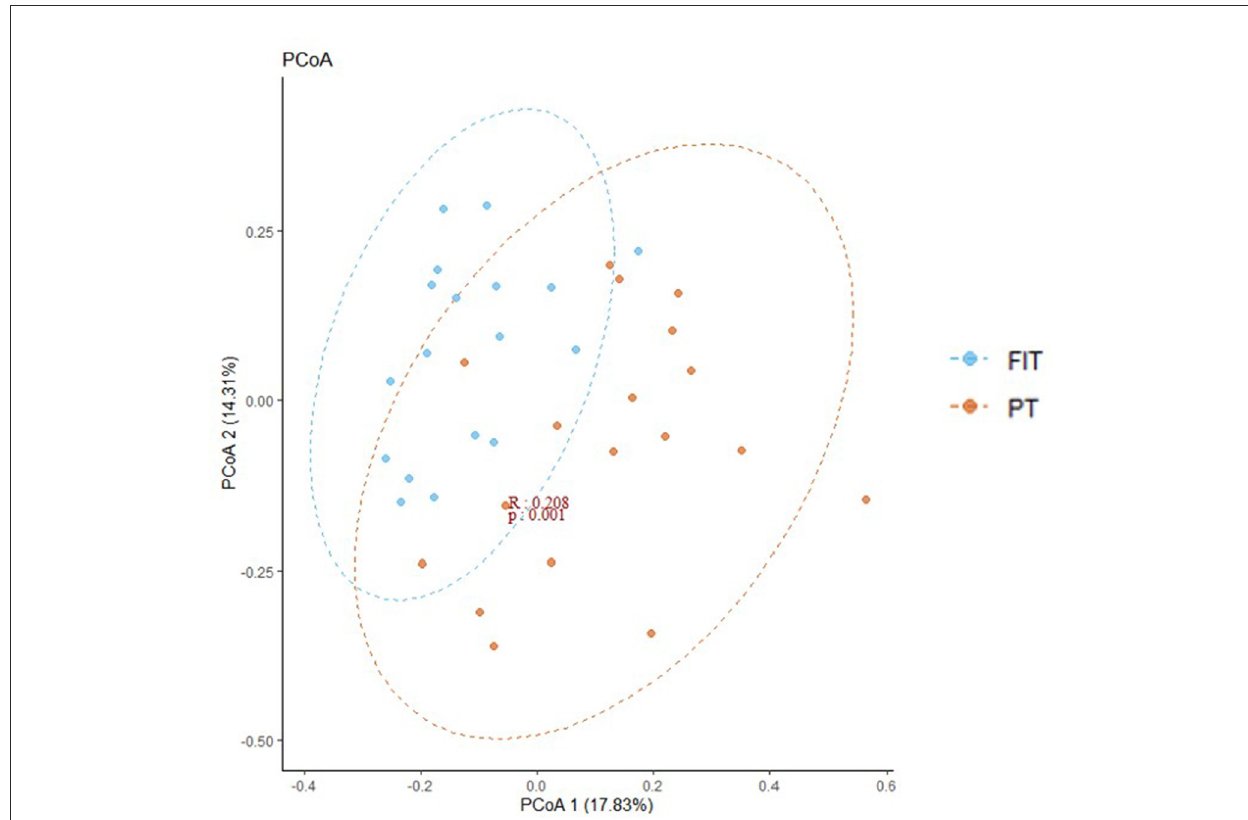
FIGURE5 Principal coordinate analysis (PCoA) ordination of wild pollinator communities using pan traps (PT) and flight interception traps (FIT). The ellipses indicate 95% confidence intervals.